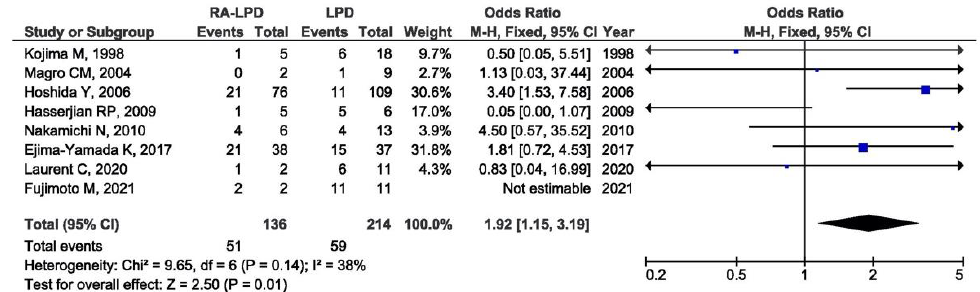
Figure 3. Meta-analysis of the difference in the positive EBV result in RA-LPD patients and all con- trols (blue dot represent the odds ratio and black frame 95% CI of the odds ratio from each of the included studies. black arrows show that upper and/or lower limit of the 95%CI of odds ratio is below or above defined values on the x axis).